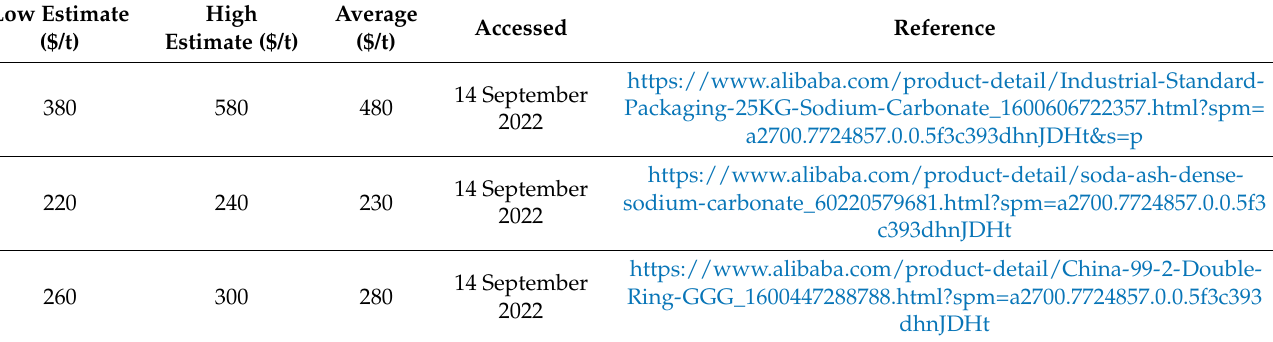
Table A1. Bulk Vendor Costs for Na 2 CO 3